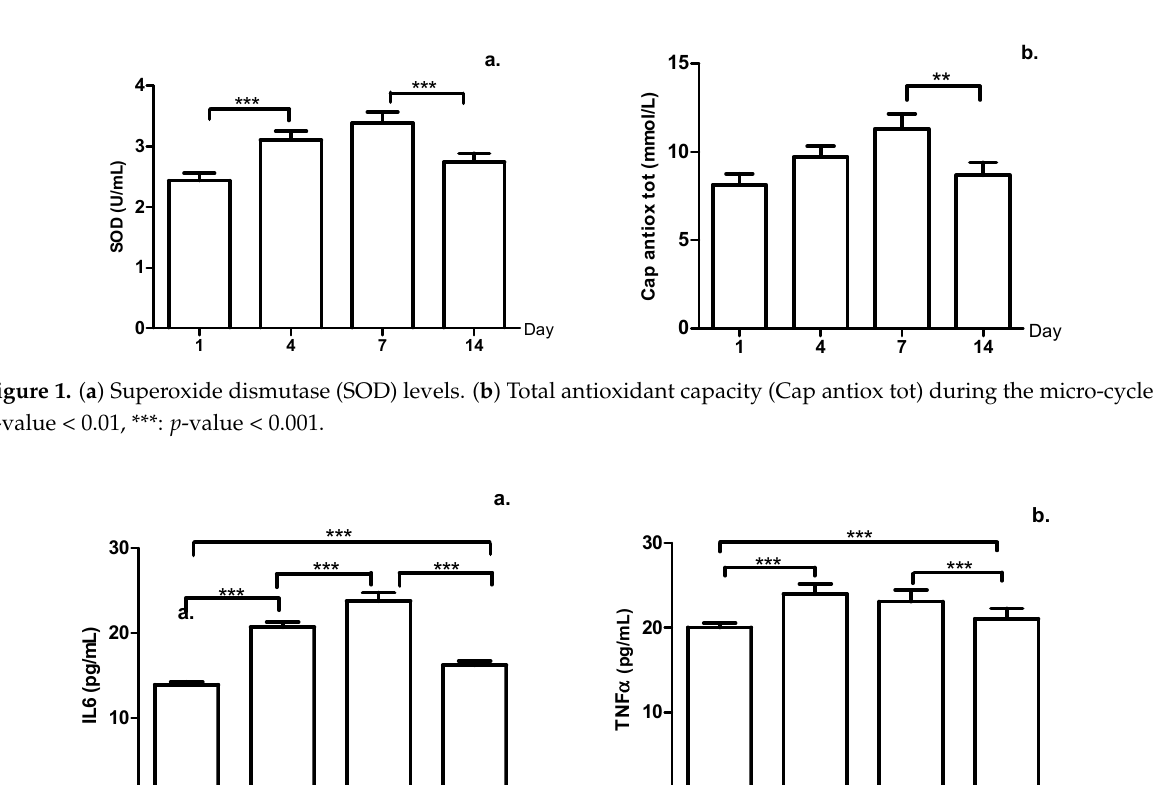
Figure 2. ( a ) Levels of Interleukin-6 (IL6); ( b ) levels of Tumor Necrosis Factor-alfa (TNF α ) during the micro-cycle, ***: p - value < 0.001.